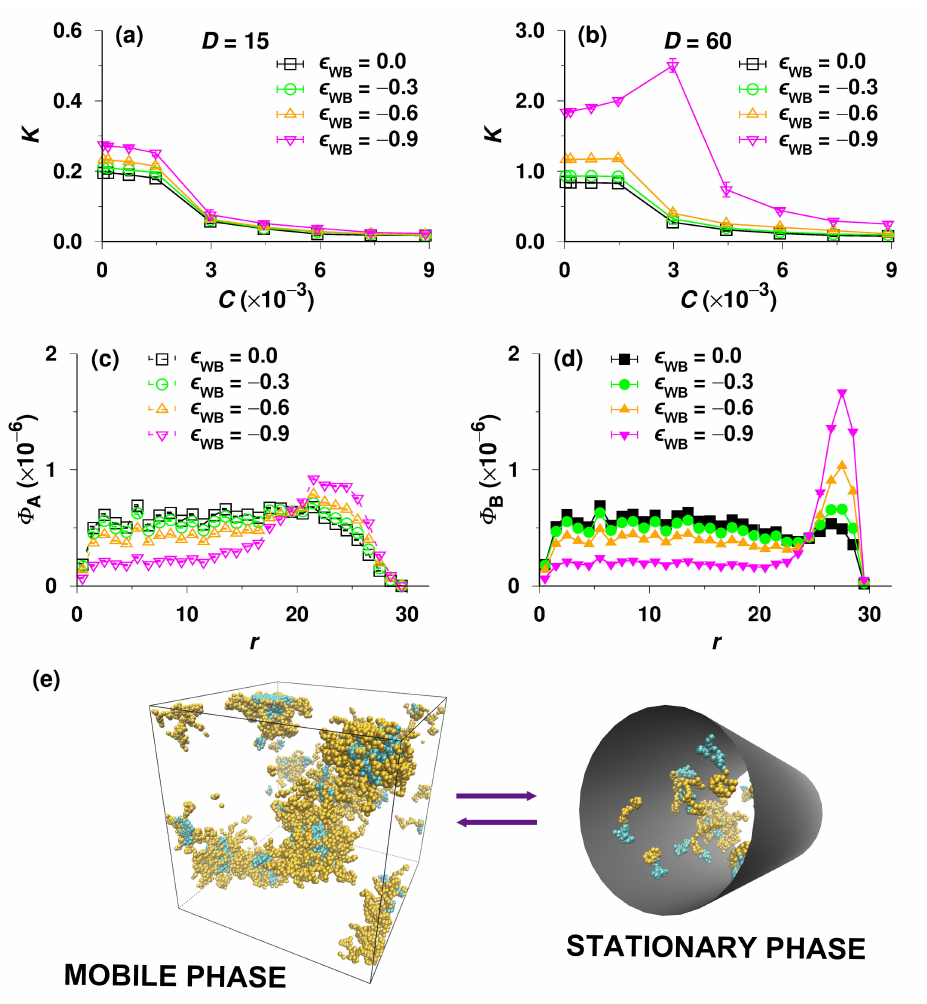
Figure 7. ( a ) Partition coefficient, K , of A32B32 copolymers as a function of total concentration, C , for various adsorption strengths, (cid:101) WB . The diameter of cylindrical pore D = 15. ( b ) K vs. C for various (cid:101) WB for D = 60. ( c , d ) The concentrations of beads A and B, Φ A and Φ B , in the cylindrical pore of D = 60 as functions of the distance to the pore center in the plane perpendicular to the pore axis, r , for various (cid:101) WB . ( e ) Snapshots of both the mobile phase (bulk) and the stationary phase (pore) for C = 8.9 × 10 − 3 , D = 60, and (cid:101) WB = −